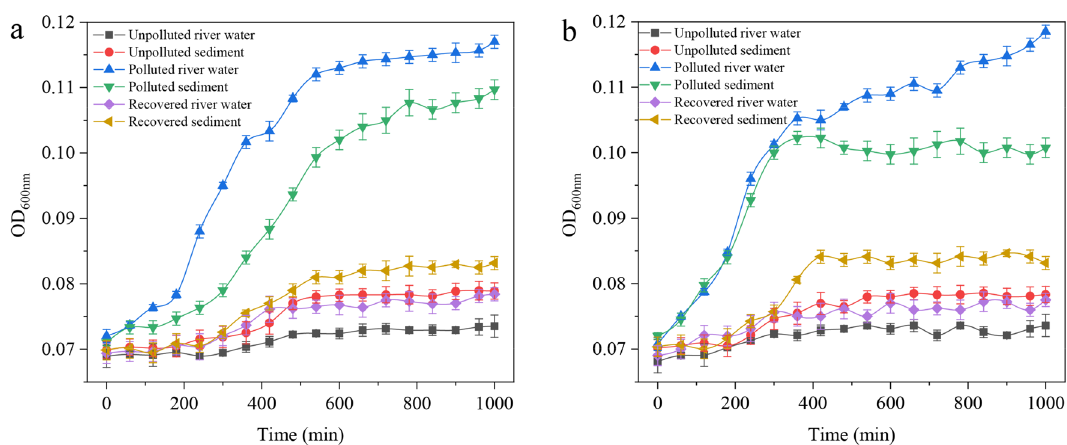
Figure 5. Growth of Staphylococcus aureus ( a ) and Escherichia coli ( b ) in different culture